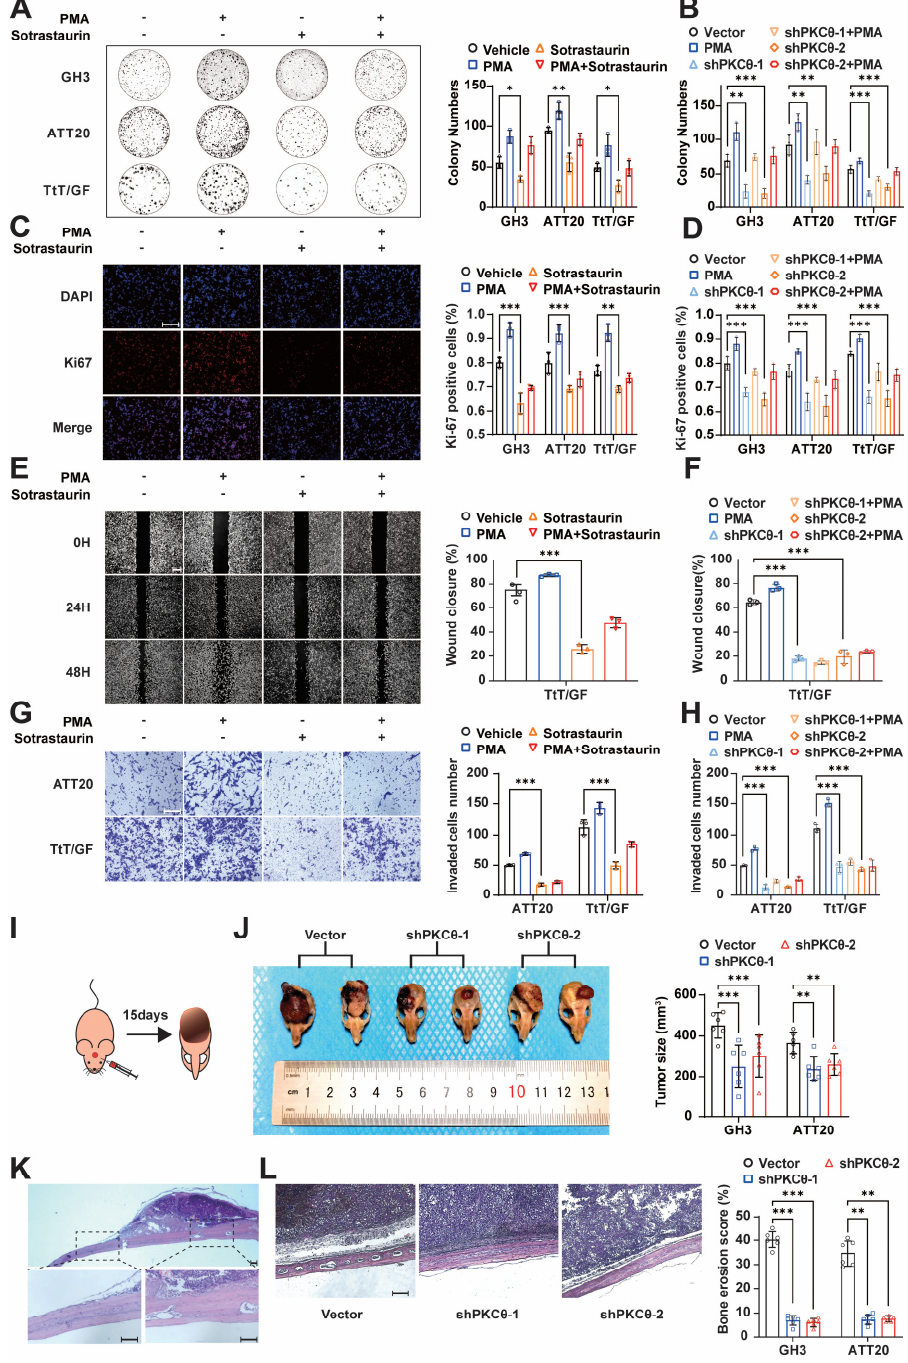
Figure 3. PKC θ is associated with proliferation, migration, and bone invasion of PAs. ( A , B ) The colony formation of PA cell lines treated with PMA and sotrastaurin ( A ). Quantification, right. The statistical chart of colony formation of shPKC θ in PA cell lines ( B ). ( n = 3 independent experiments; *** p < 0.001; ** p < 0.01; * p < 0.05) ( C , D ) The Ki-67 staining of GH3 cells treated with PMA and sotrastaurin ( C ) ( × 200; scale bar, 200 µ m). Quantification with ATT20 and TtT/GF, right. The statistical chart of Ki-67 staining of shPKC θ in PA cell lines ( D ). ( n = 3 independent experiments; *** p < 0.001; ** p < 0.01) ( E , F ) The wound healing assay of TtT/GF cells treated with PMA and sotrastaurin ( E ) ( × 100; scale bar, 200 µ m). Quantification, right. The statistical chart of wound healing assay of shPKC θ in TtT/GF cells ( F ) ( n = 3 independent experiments; *** p < 0.001). ( G , H ) The